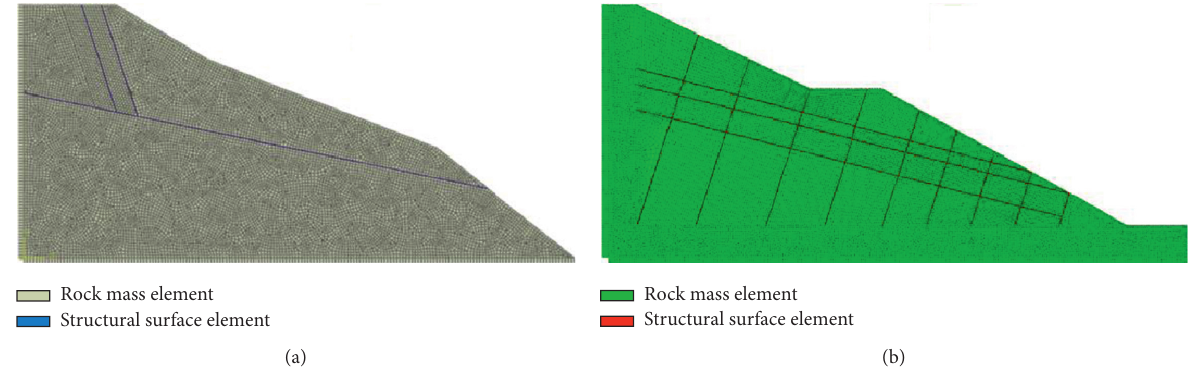
Figure 4: Mesh model used in the calculations: (a) Huaping slope; (b) Lijiang slope.